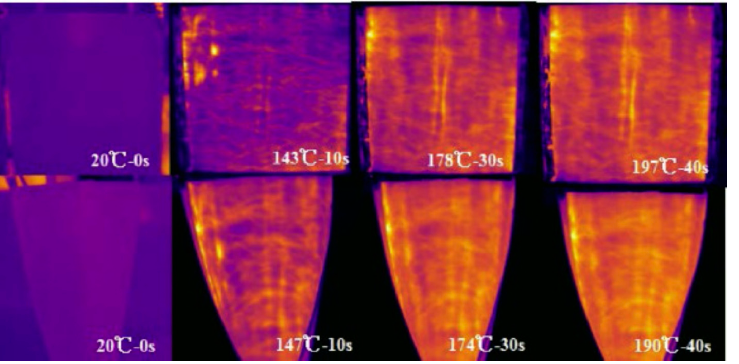
Figure 15. Temperature distribution of G-CF35/PDMS at different times at 35 V voltage not deformed and twisted states (Reprinted from Elsevier, copyright 2019) [161].